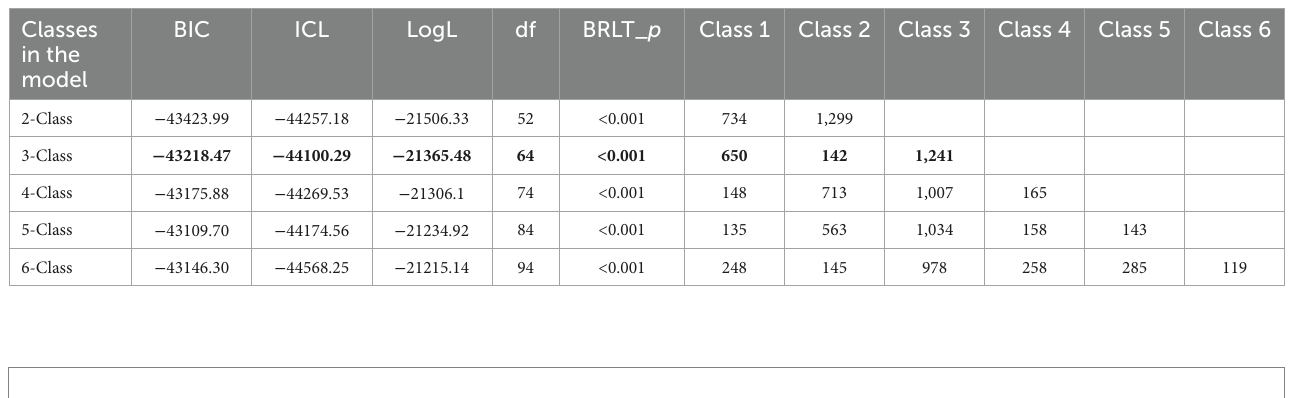
TABLE 1 Latent profile analysis model fit statistics and class membership.